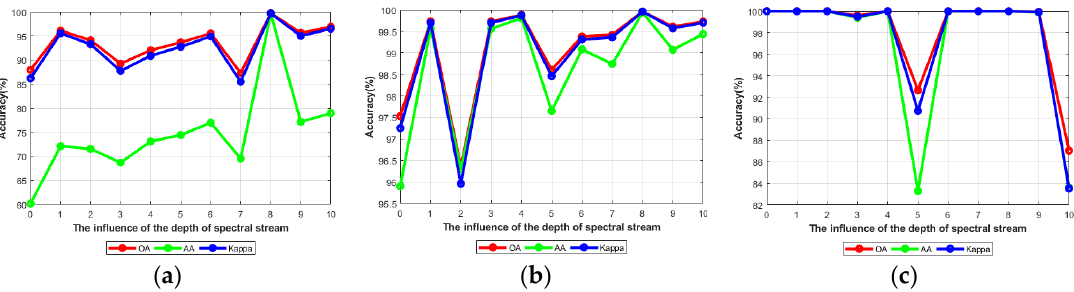
Figure 18. The influence of the depth of spectral stream. ( a – c ) represent the influence of the depth of spectral stream on IN, KSC and SA, respectively.